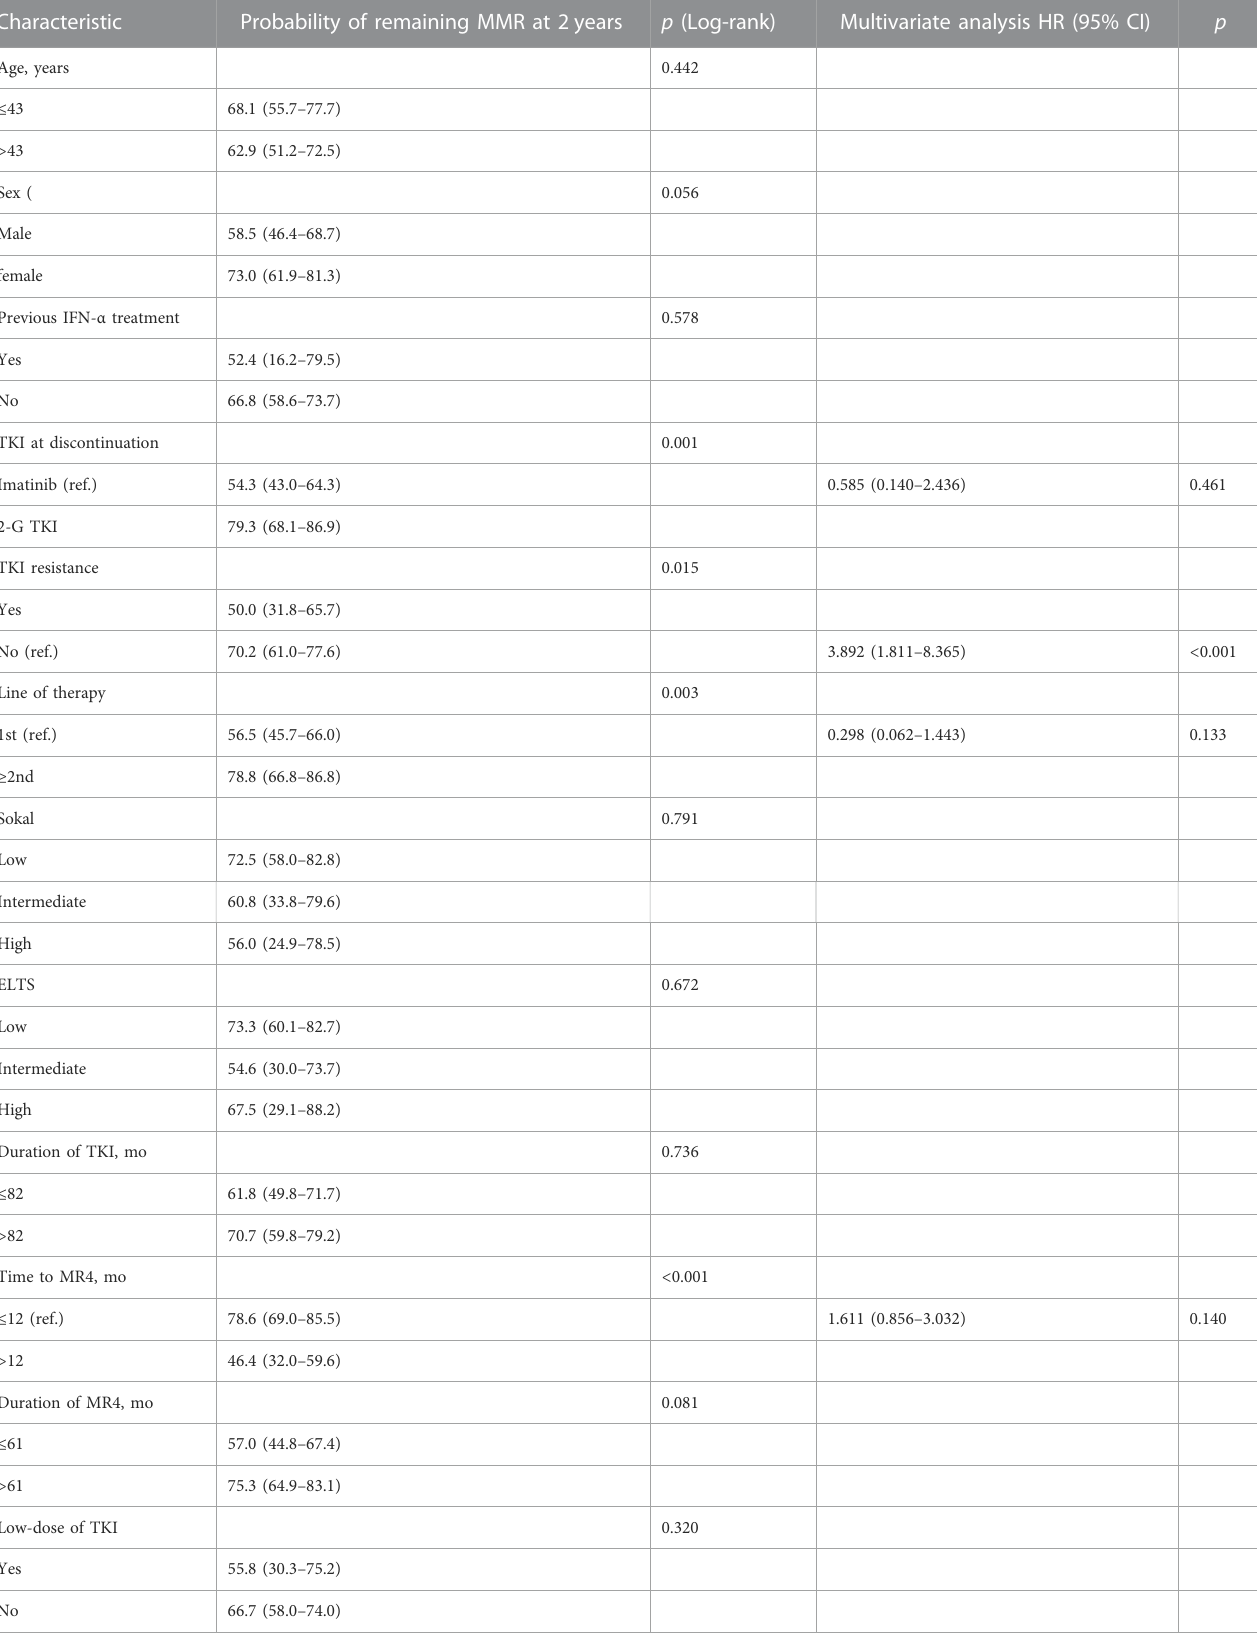
TABLE 3 Univariate and multivariable analysis of various parameters ’ associations with molecular